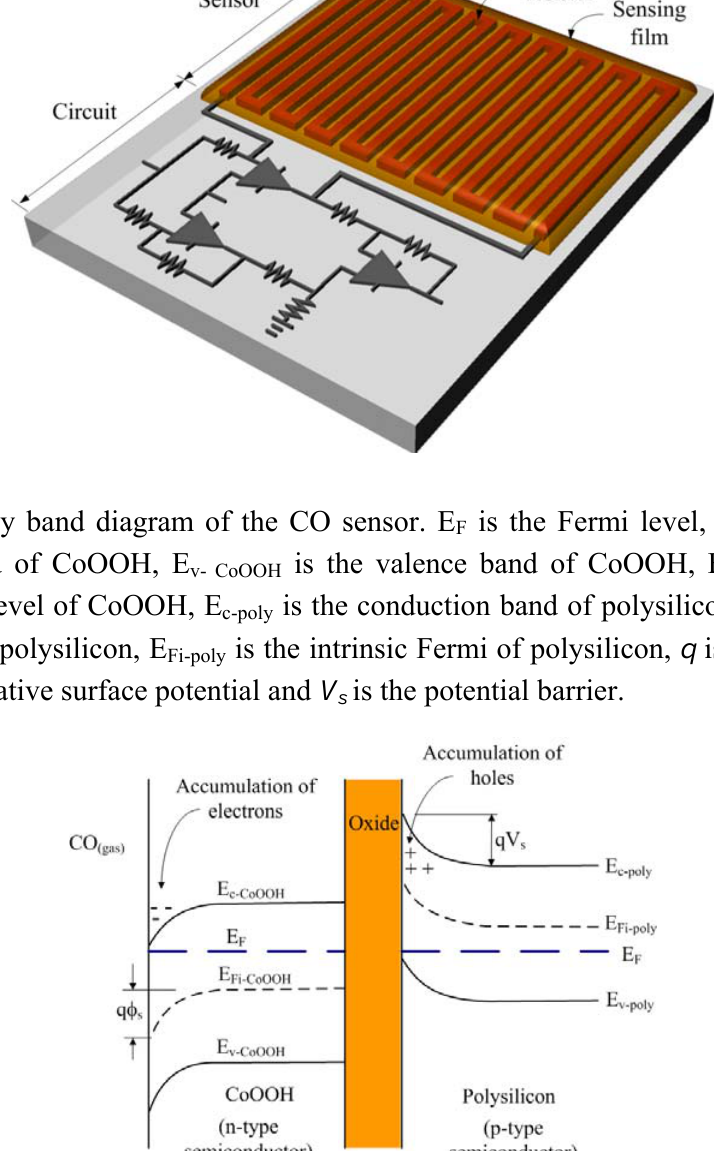
Figure 3. Schematic structure of the CO sensor with the readout circuit.